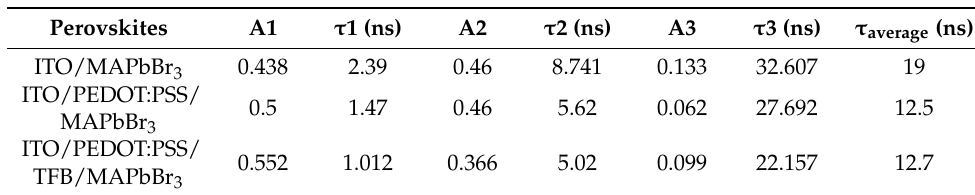
Table 1. Device performances of PeLEDs with and without TFB HTLs.